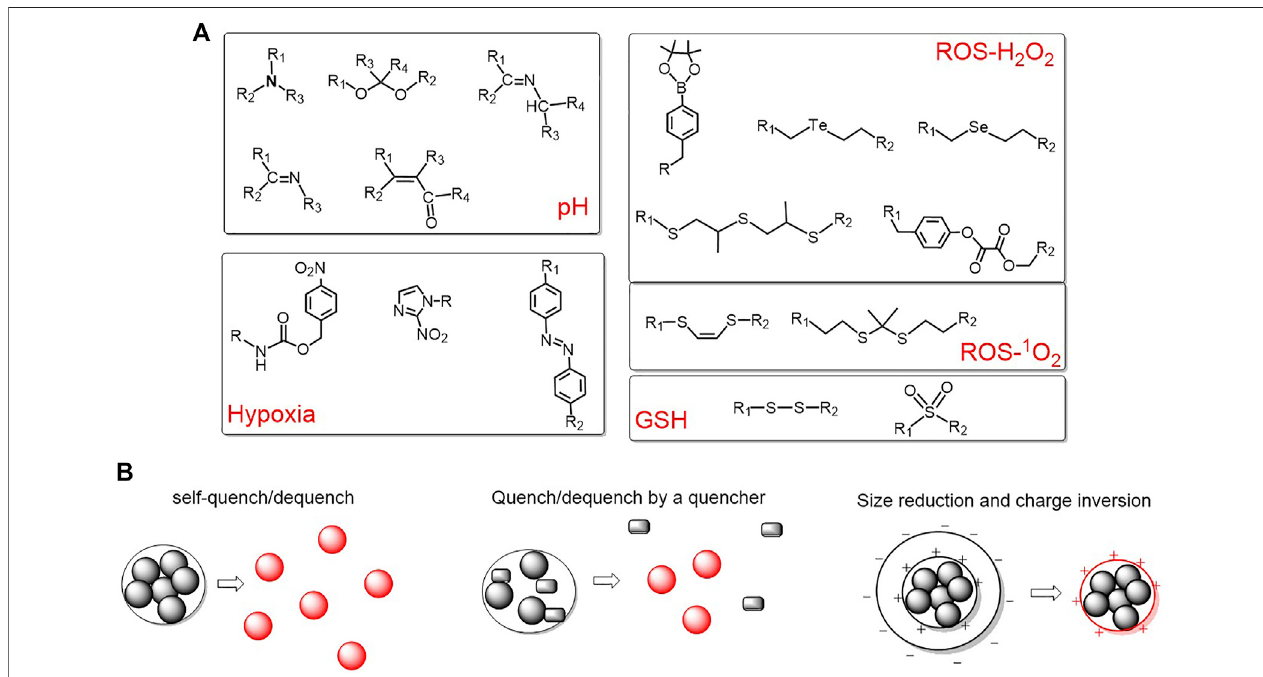
FIGURE3|(A) RepresentativepH/ROS/GSH/hypoxia-responsivelinkersforactivatablepolymericdelivery system; (B)